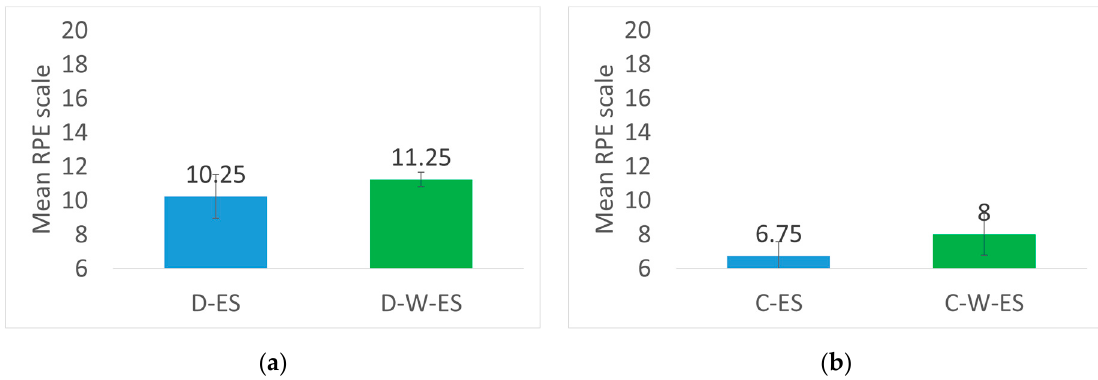
Figure 6. Mean RPE scale of the upper limb for groups C and D with and without using the PULE for: ( a ) fruit thinning of the jujube tree; ( b ) pesticide spraying of the pomelo tree.